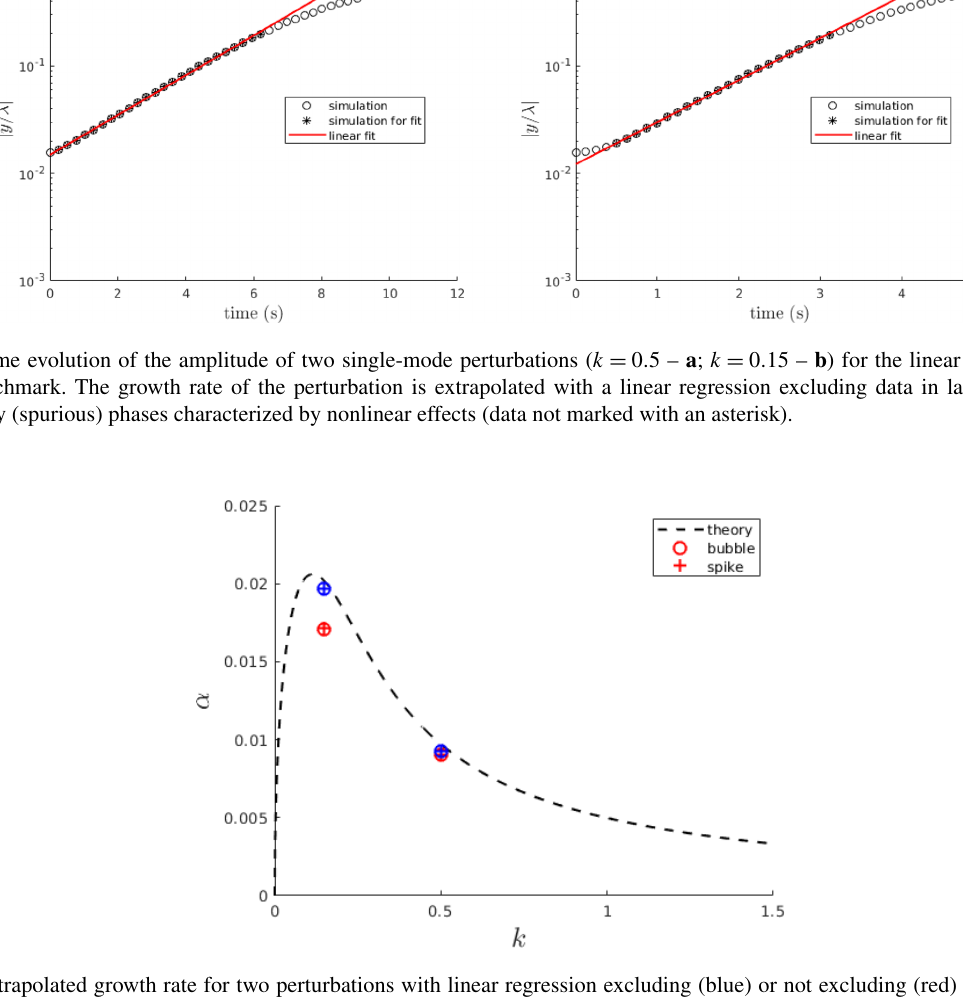
Figure A2. Extrapolated growth rate for two perturbations with linear regression excluding (blue) or not excluding (red) data in the initial phase characterized by nonlinear spurious